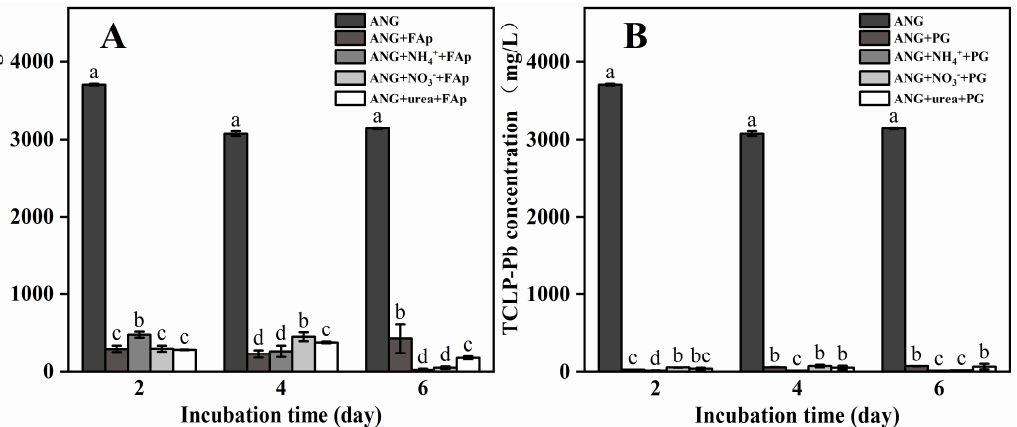
Figure 5. Concentrations of TCLP-Pb in the FAp ( A ) and PG ( B ) treatments during the incubation (2, 4, and 6 days). The different lower-case letters indicate a significant difference between the treatments ( p < 0.05). The significant differences among the treatments were identified by Tukey test ( p < 0.05) via one-way ANOVA.